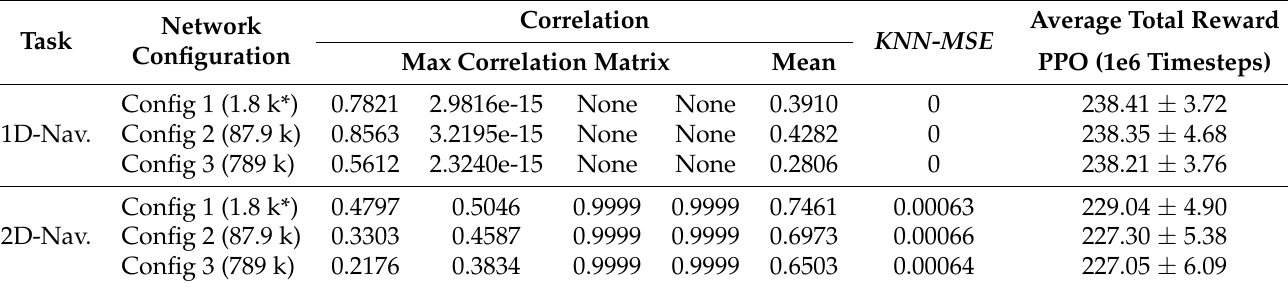
Table 3. The influence of the network configuration in mobile robot navigation task.